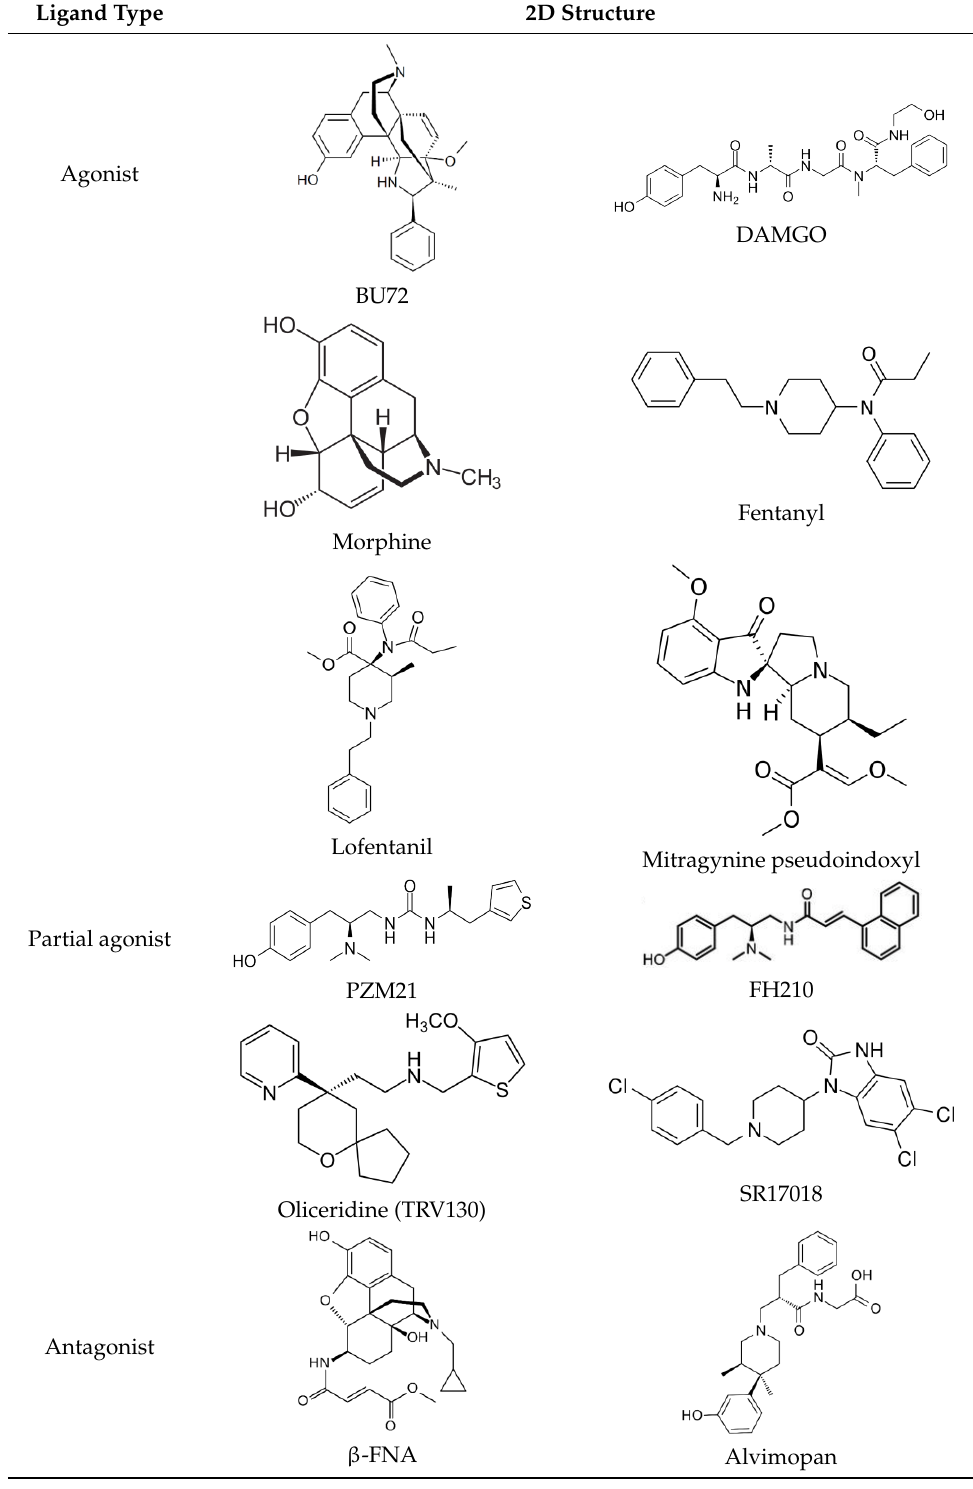
Table 3. The 2D structures of the ligands.